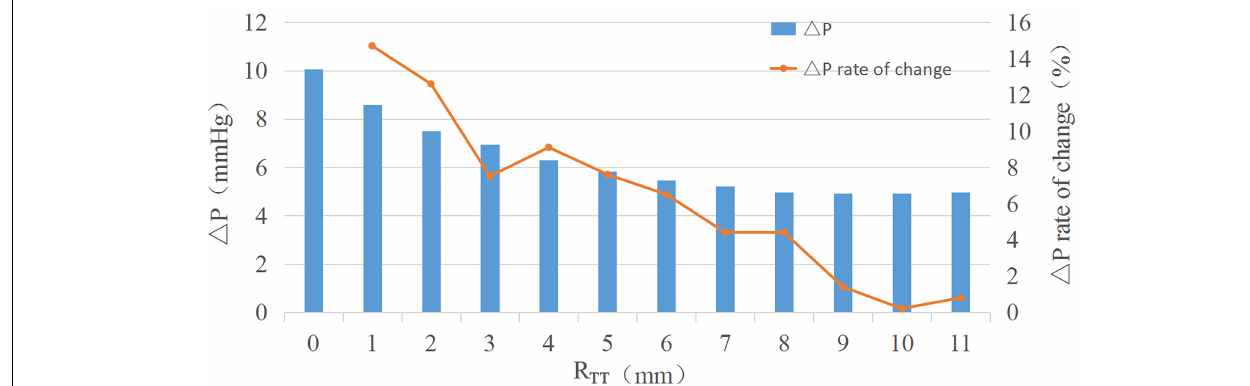
FIGURE 2 | (cid:77) P-R TT and (cid:49) P rate of change-R TT .